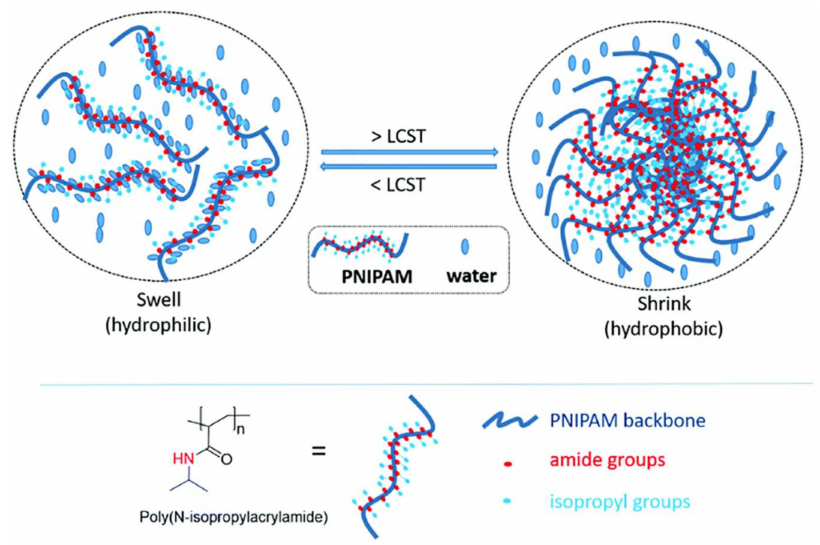
Figure 36. Thermo-responsive drug release by PNIPAM hydrogel (reproduced from [160] with permission from the Royal Society of